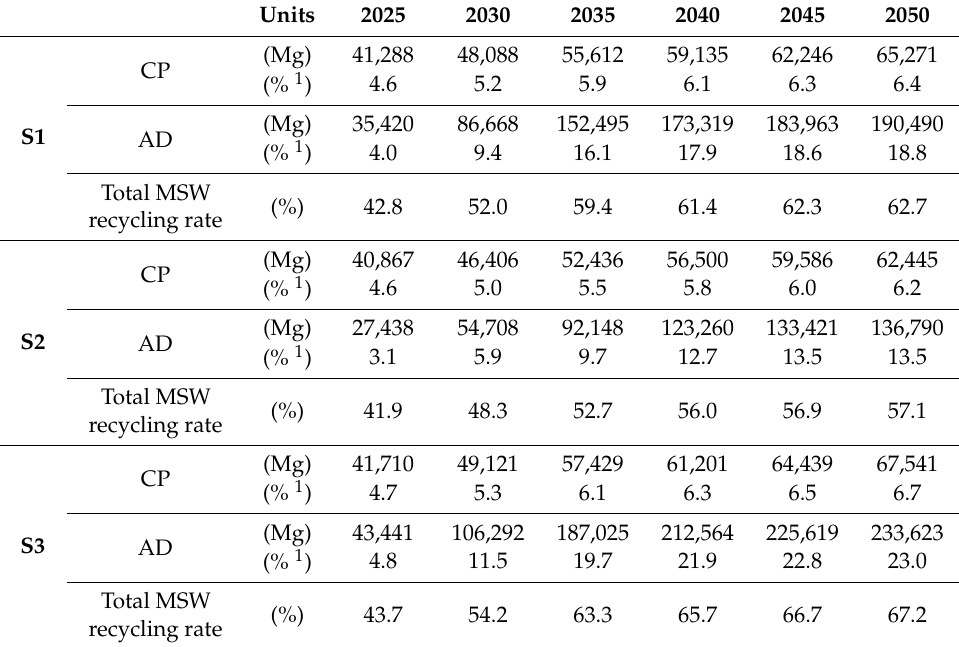
Table 6. TS-III material flow of biowaste in recycling process and MSW recycling rate achieved.